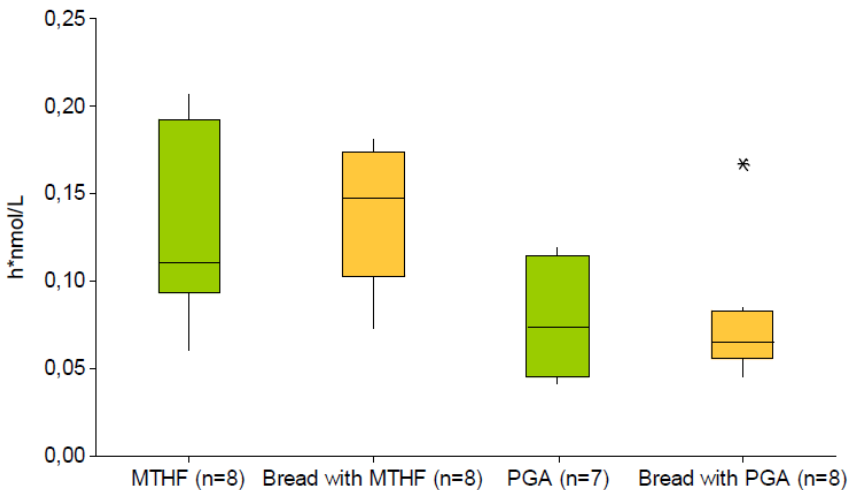
Figure 2 . Dose-normalized AUC of plasma [ 13 C after single oral equimolar folate doses (≈450 nmol = 200 µg) in the form of pharmaceutical preparation with (6 S )-[ 13 C [ 13 C ]folic acid (PGA, green) or as bread fortified with (6 S )-[ 13 C 5 (bread with MTHF, orange) or [ 13 C Data from